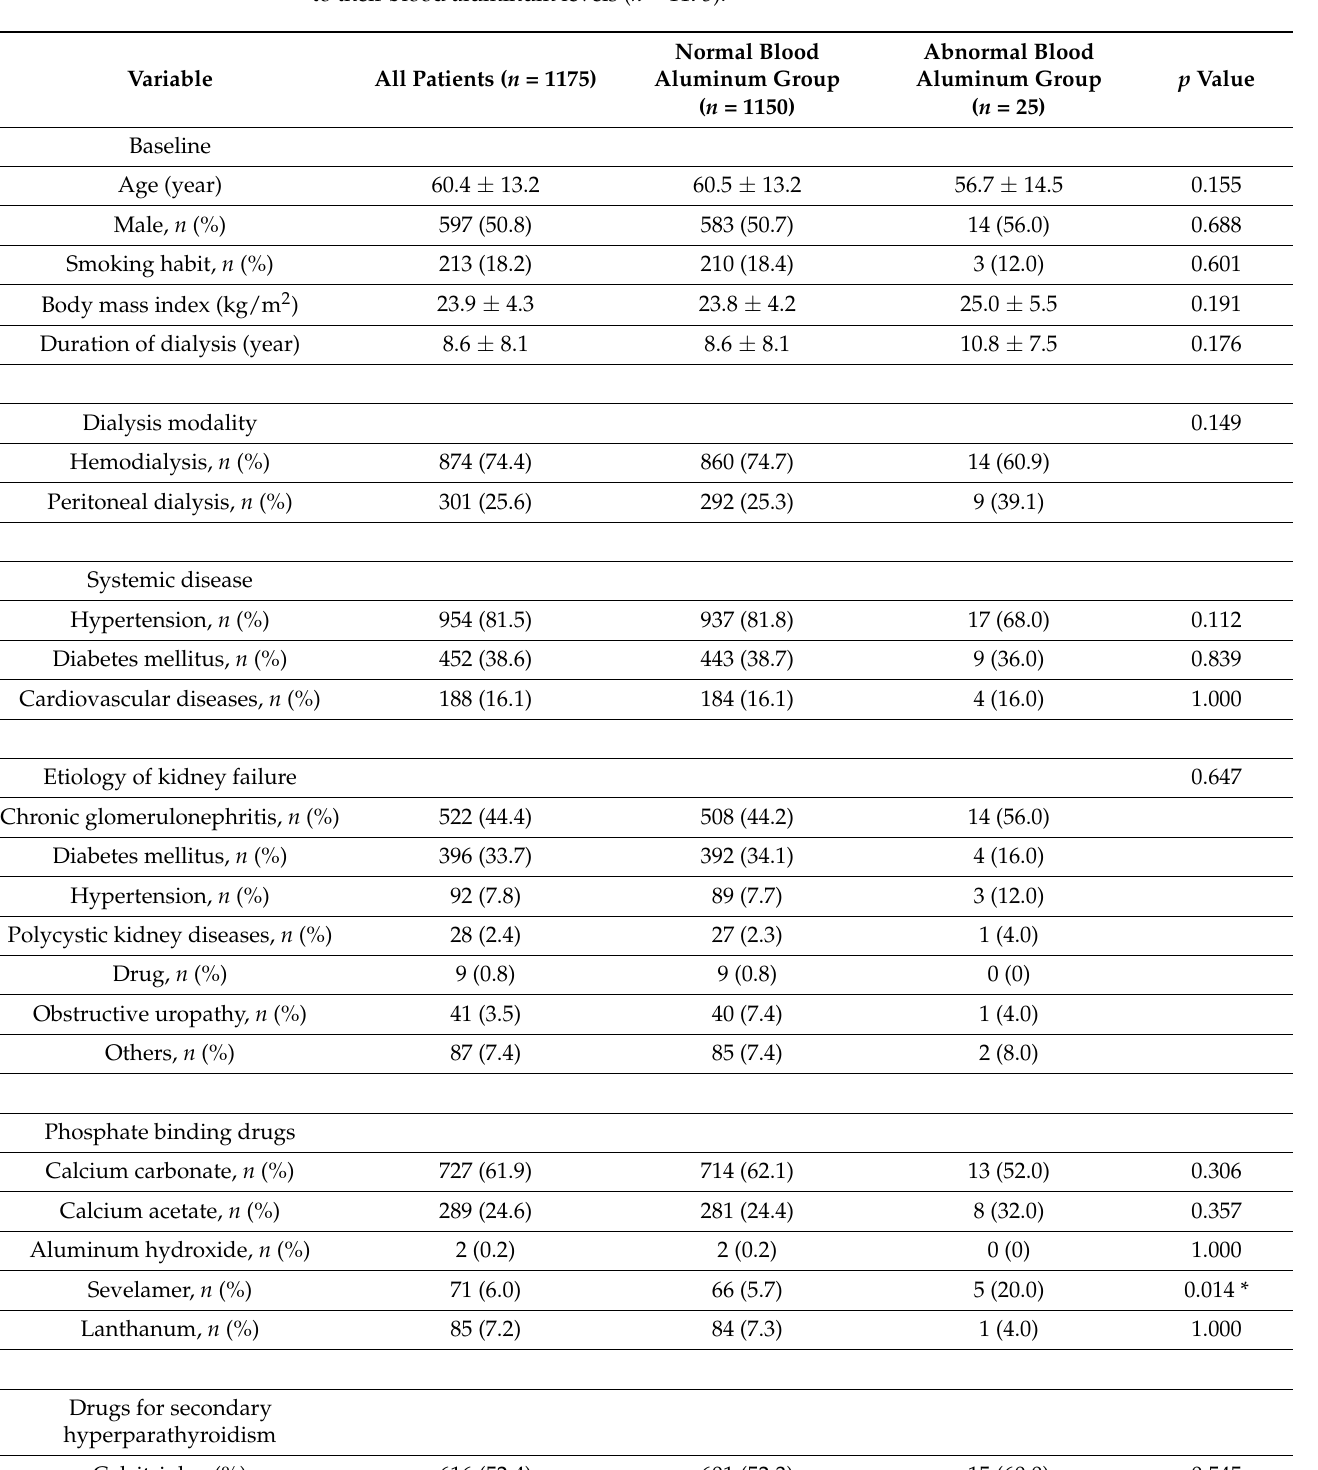
Table 1. Baseline demographics of hemodialysis and peritoneal dialysis patients, stratified according to their blood aluminum levels ( n =